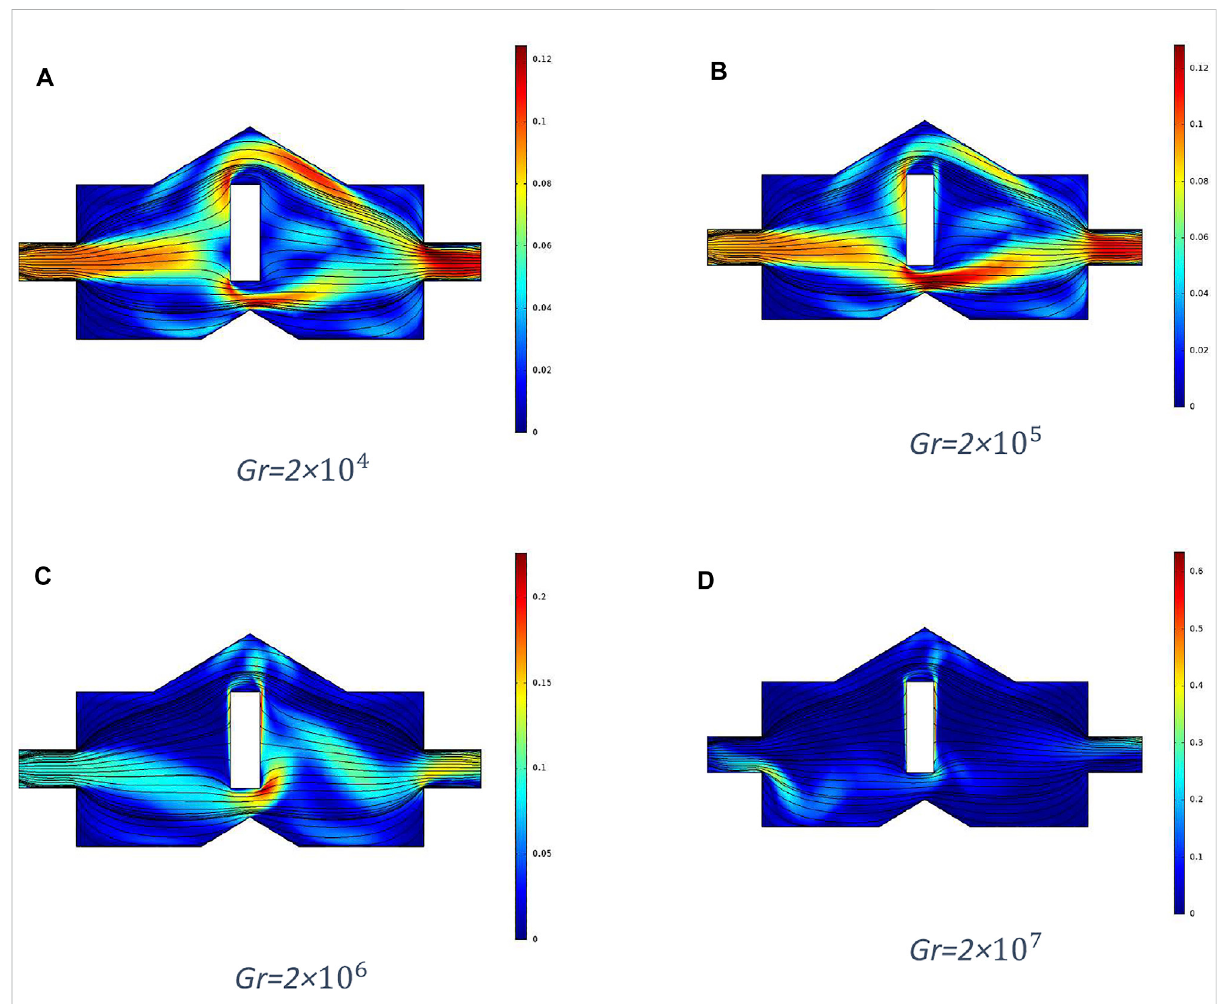
Streamlines at Re = 1,000 and at different Grashof